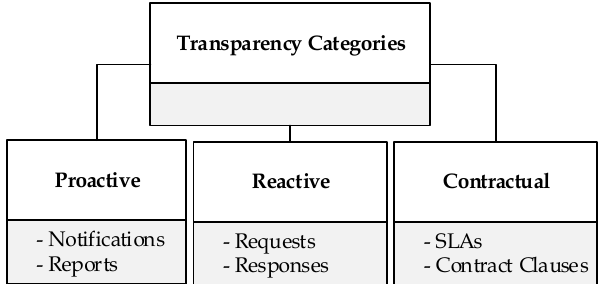
Figure 1. Categorisation of cloud security transparency.